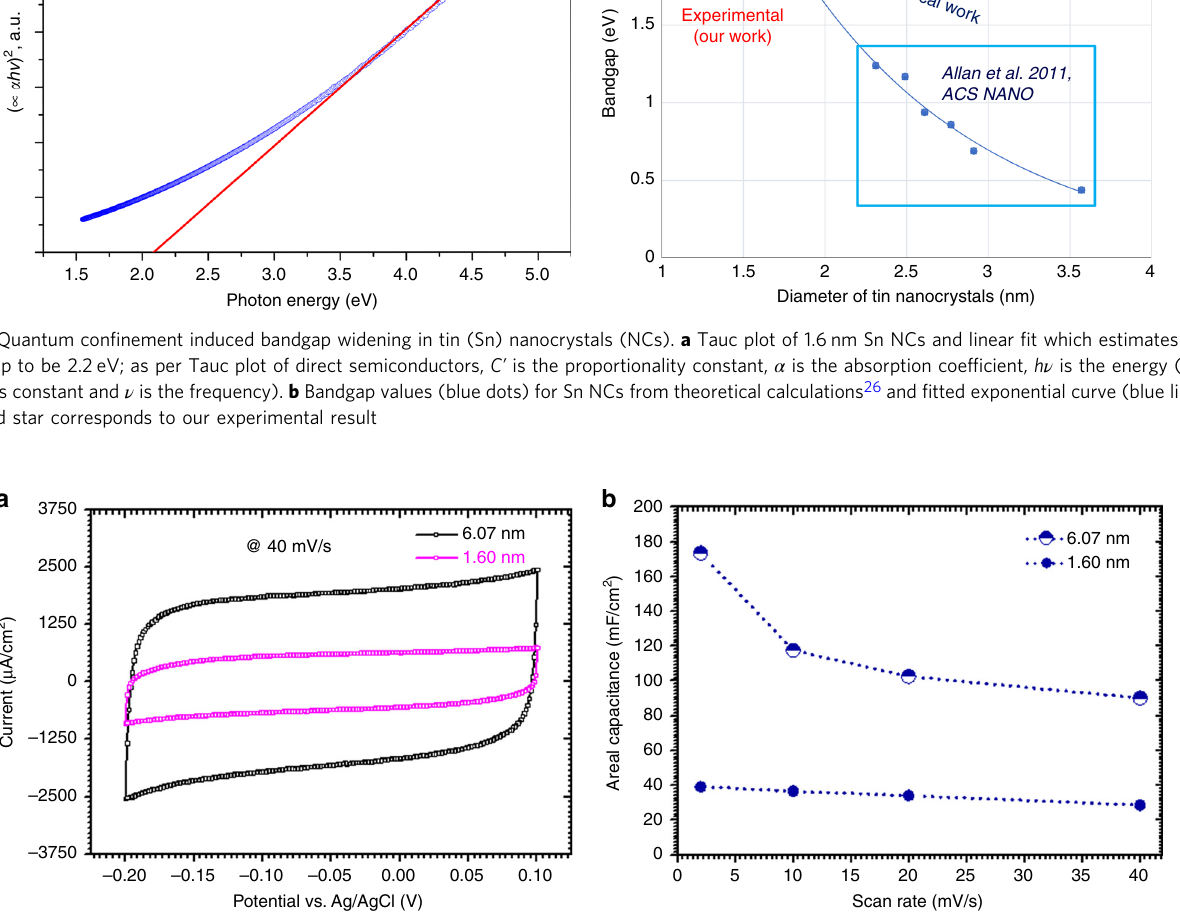
Fig. 5 Electrochemical performance of tin (Sn) nanocrystals. a Cyclic voltammograms of tin (Sn) nanocrystals (NCs) in 0.1 M sodium hydroxide (NaOH) solution attained at scan rate 40 mV s − 1 respectively; b evolution of the relative areal capacitances of Sn NCs versus scan